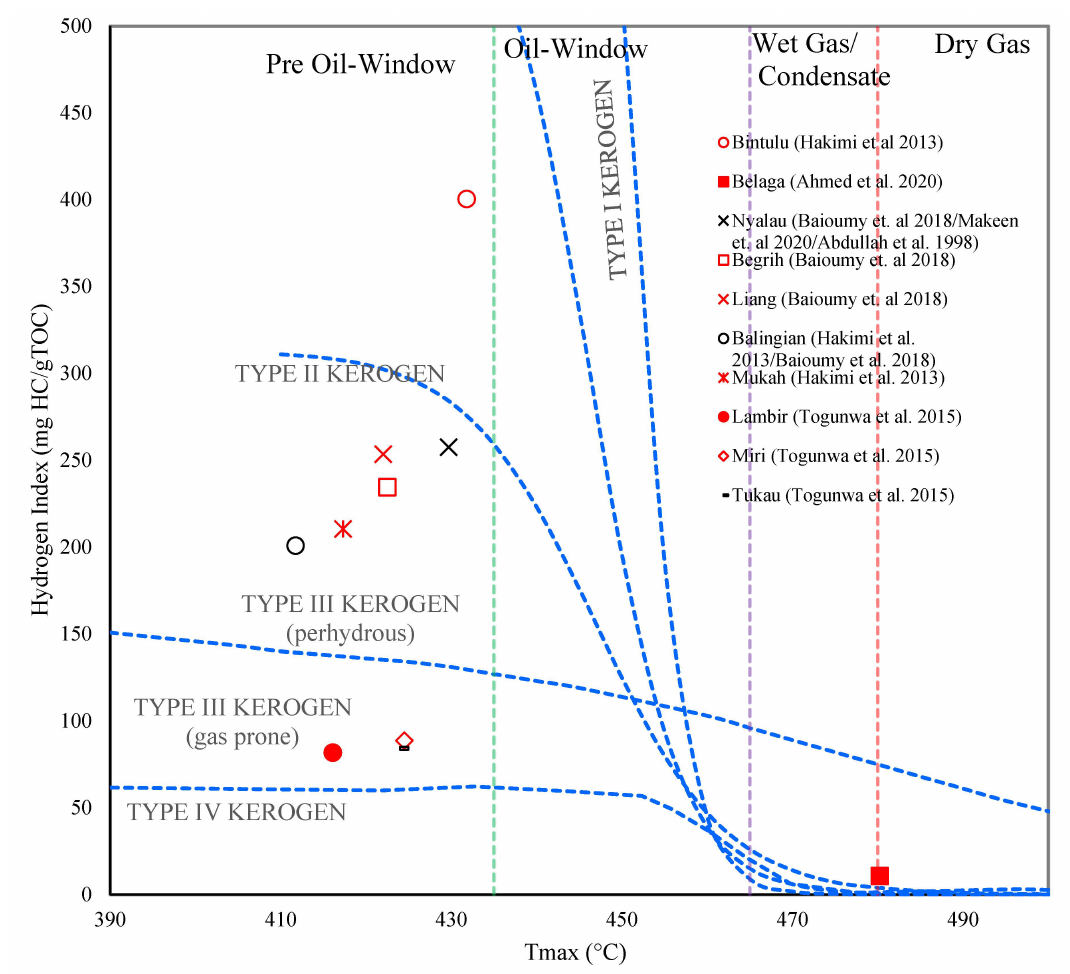
Figure 16. Tmax vs. PI plot showing kerogen maturity level of formations in Sarawak.